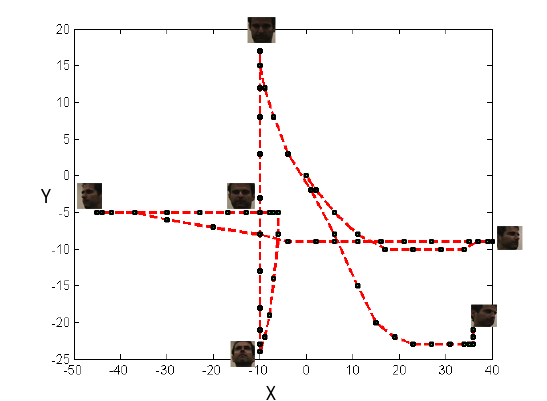
Figure 4. Variation of dx and dy in one video sequence of the Honda/UCSD